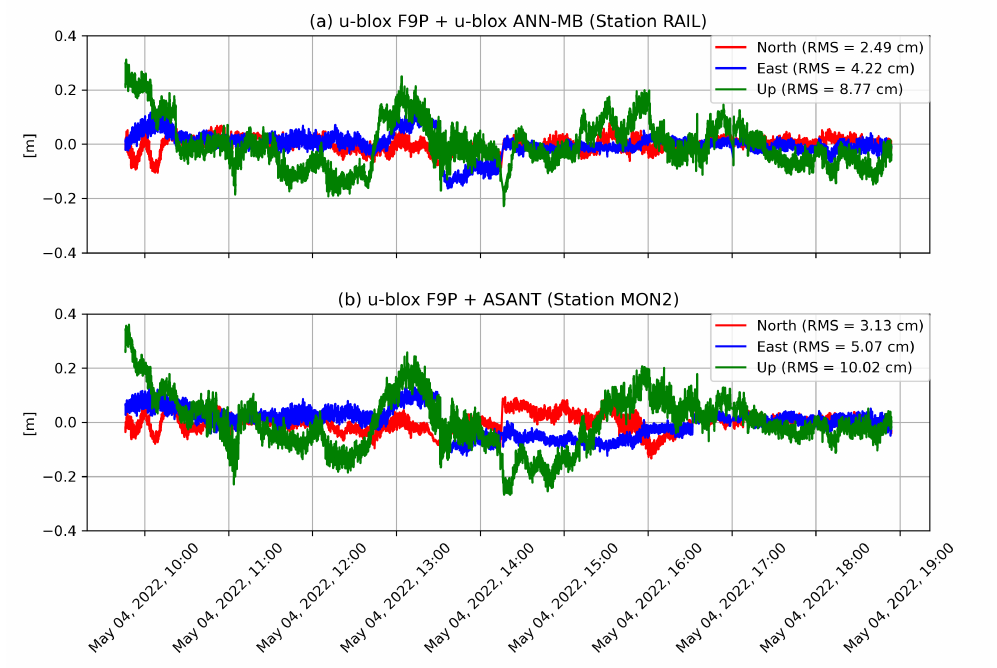
Figure 17. Session 3—sub-session 4: results for the kinematic displacements obtained from the static experiments—PPP-RTK solution obtained with